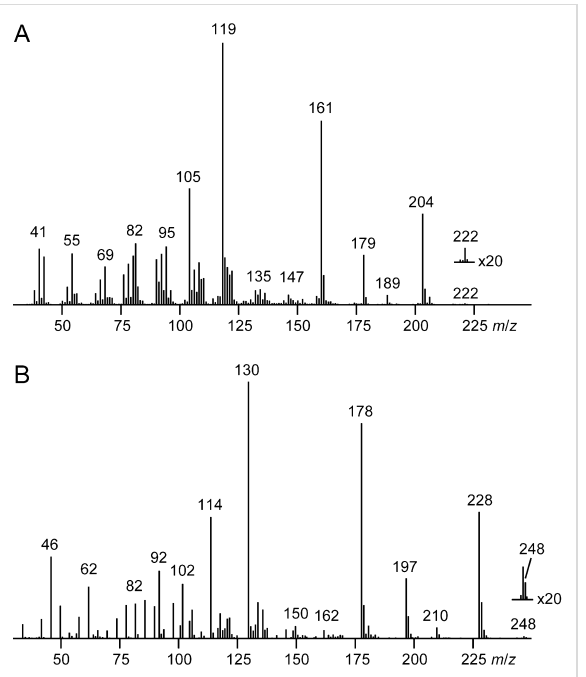
Figure 3: Mass spectra of 1- epi -cubenol. (A) Mass spectrum of natural 3 obtained after growth on 65.GYM; (B) mass spectrum of [ 2 H 26 ]- 3 obtained after growth on DMM.